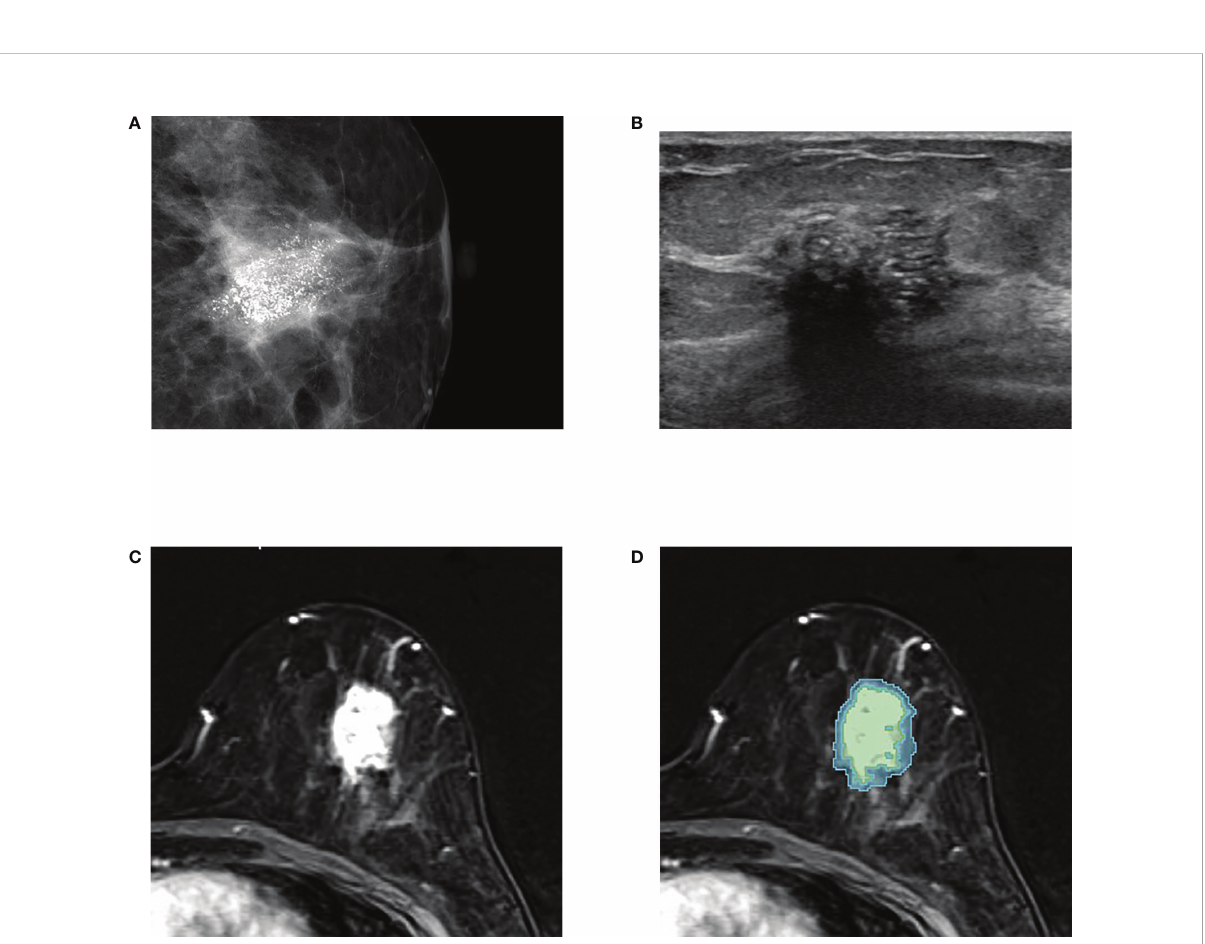
FIGURE 2 An example of tumor segmentation in a 50-year-old woman who complained of palpable lump in her left breast, which was pathologically con fi rmed as upgraded ductal carcinoma in situ (DCIS) after surgical excision. (A) Mammography shows about 3 cm extent of fi ne pleomorphic microcalci fi cations seen in the left central breast. (B) Ultrasound image shows the non-mass lesion with microcalci fi cations. (C) Axial fi rst postcontrast T1-weighted image with subtraction shows a 3 cm irregular heterogeneously enhancing mass in left lower central breast. (D) The green and blue shadings represent the intratumor and peritumor ROIs, respectively, which are created by 3D